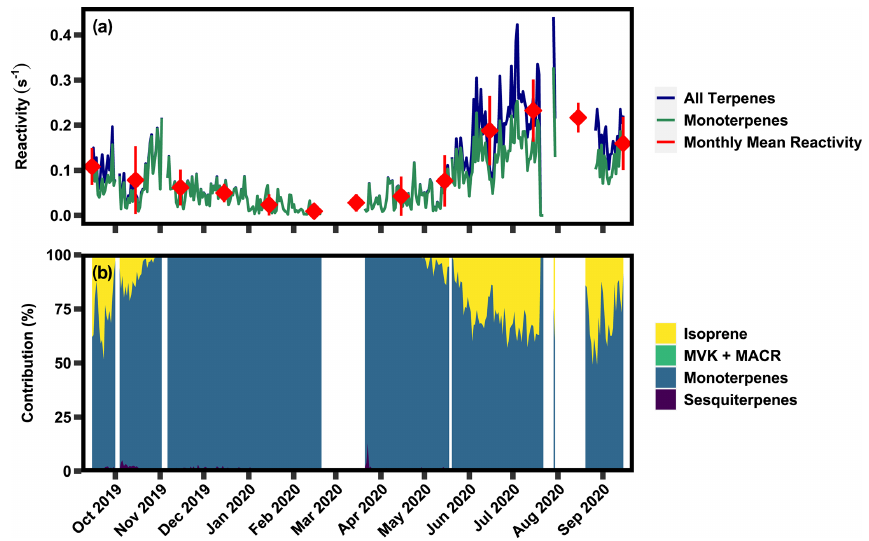
Figure 7. (a) Time series of 24h averaged calculated nitrate reactivity of all terpene classes and the monoterpene class, as well as the monthly mean of calculated nitrate reactivity. (b) Relative contribution of each of the BVOC classes to nitrate